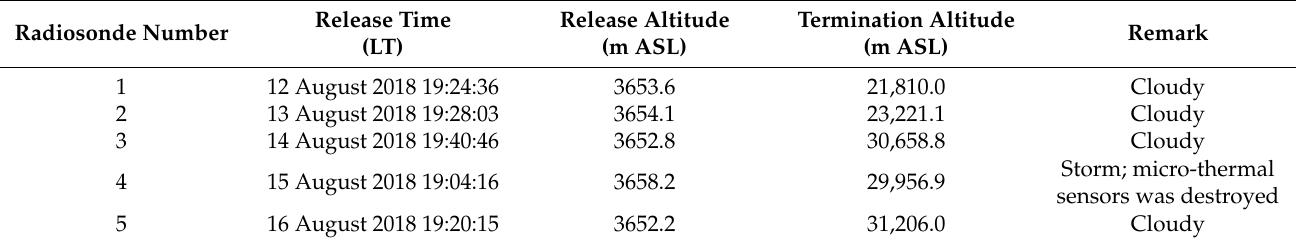
Table 1. Detailed records of radiosonde experiments over the